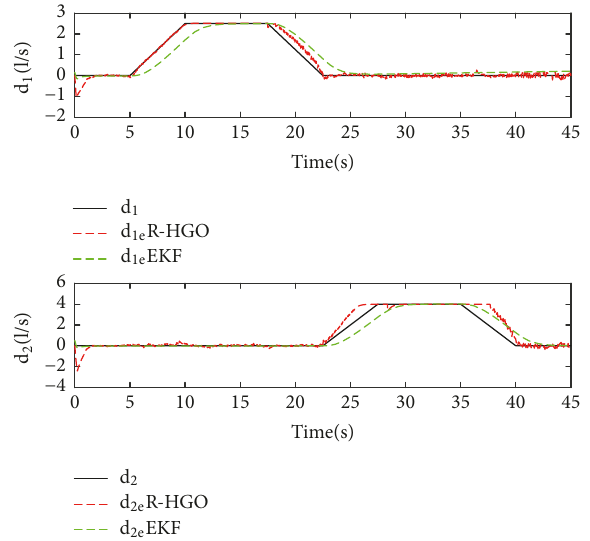
Figure 4: Estimation of the leakage flow rates